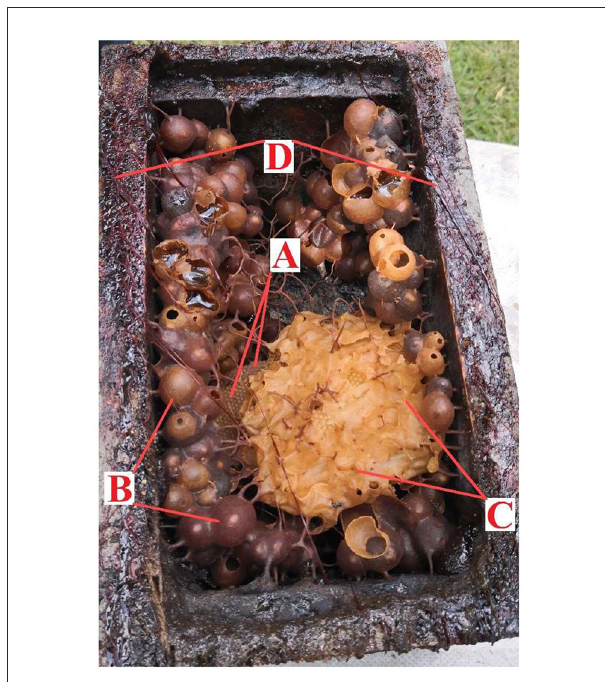
FIGURE1 Stingless bee honeycomb structure of Plebeia jorentei : brood nest (A) , storing pots of honey and pollen (B) , protective wax (C) , and propolis to seal (D)